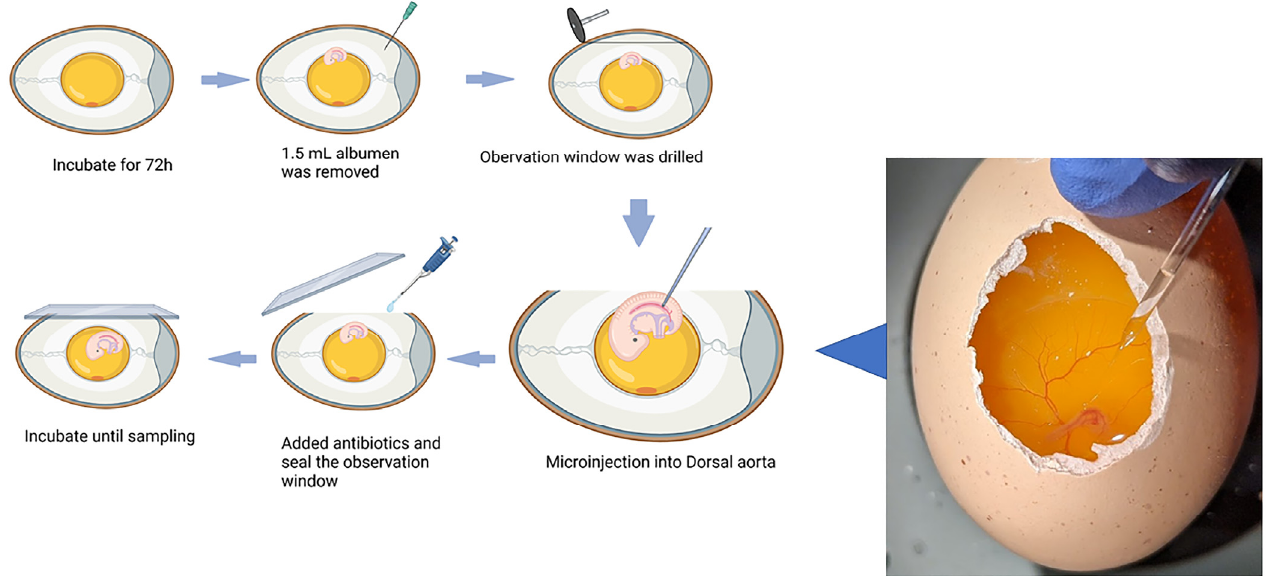
Figure 1. Illustration of the microinjection of chicken embryos at ED 3. The dorsal aorta was pierced using the tip of a micropipette, and the same volume of a hydrogen peroxide (H 2 O 2 ) solution at different concentrations was injected into Cobb500 embryos. Glass coverslips (24 × 55 mm) were used to seal the observation windows, and the treated embryos were returned to the incubator without turning. Illustration created with BioRender.com.